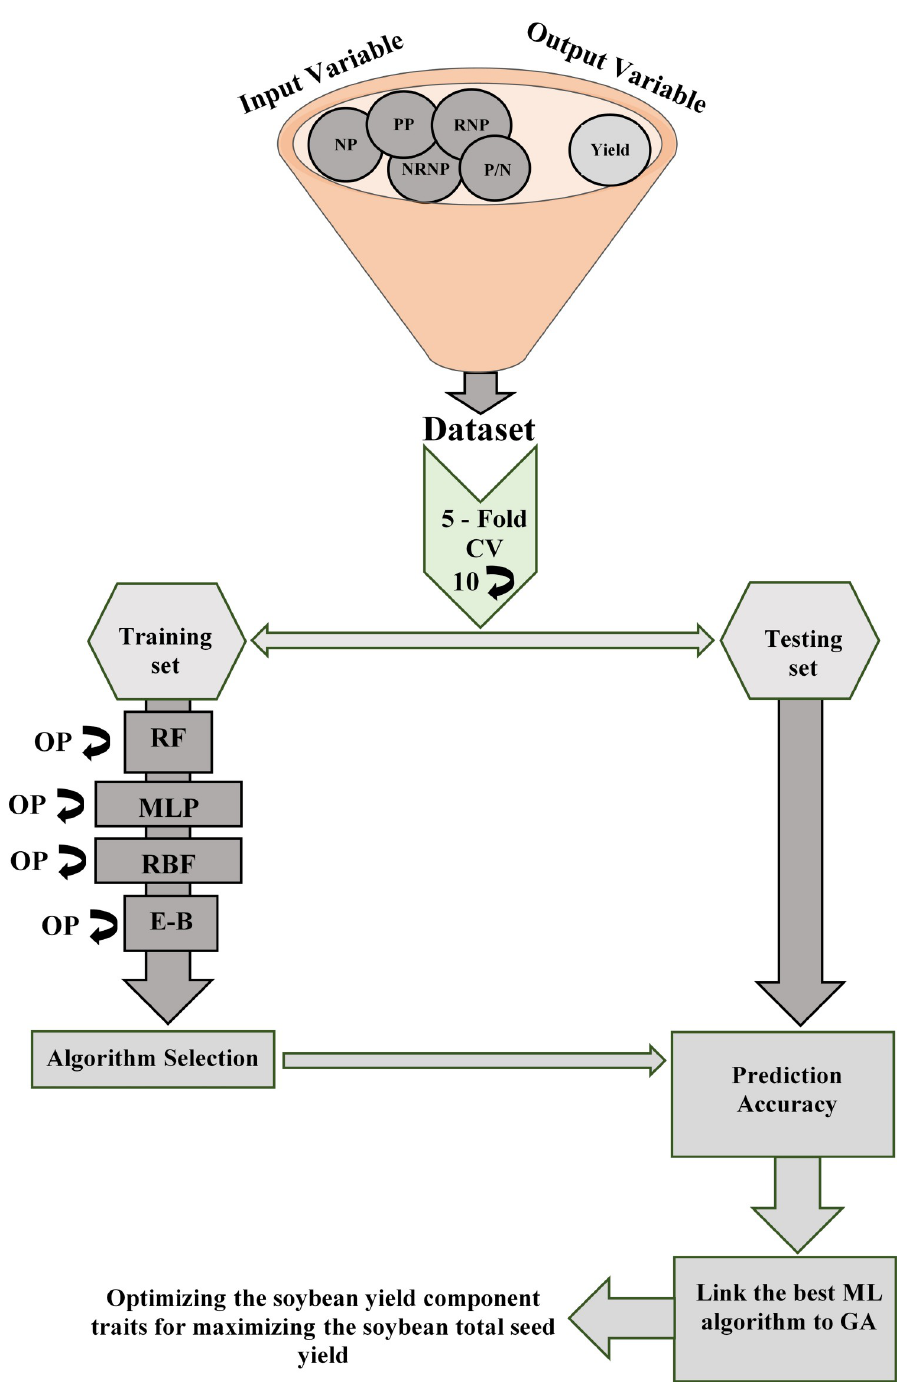
Fig 2. The experimental workflow of algorithm selection and validation for predicting the soybean seed yield. The Number of Nodes per plant (NP), the Number of Non-Reproductive Nodes per Plant (NRNP), the Number of Reproductive Nodes per Plant (RNP), and the Number of Pods per Plant (PP), the ratio of number of Pods to number of Nodes per plant (P/N), Genetic Algorithm (GA).